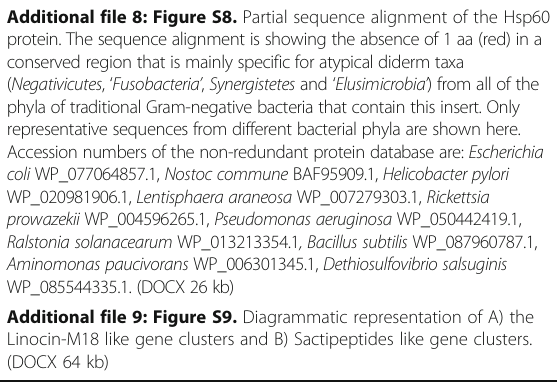
Additional file 9: Figure S9. Diagrammatic representation of A) the Linocin-M18 like gene clusters and B) Sactipeptides like gene